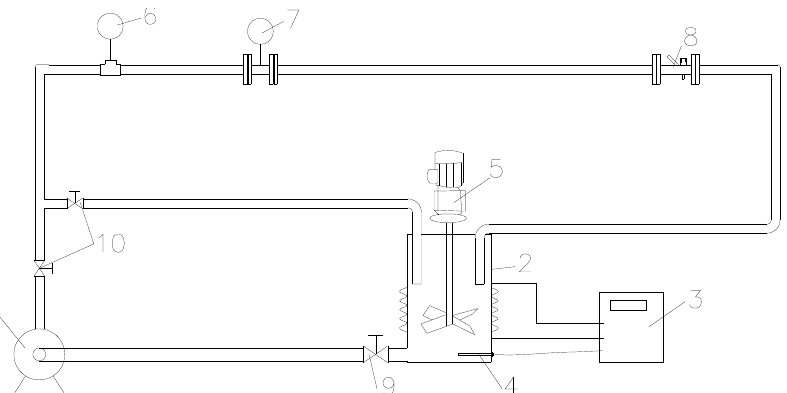
Figure 1. Schematic diagram of the erosion-corrosion testing rig (1—slurry pump, 2—slurry tank, 3—cryostat circulator, 4—thermocouple, 5—stirrer, 6—pressure gage, 7—electromagnetic flowmeter, 8—pipe flow testing section, 9—ball valve, 10—stop valve).